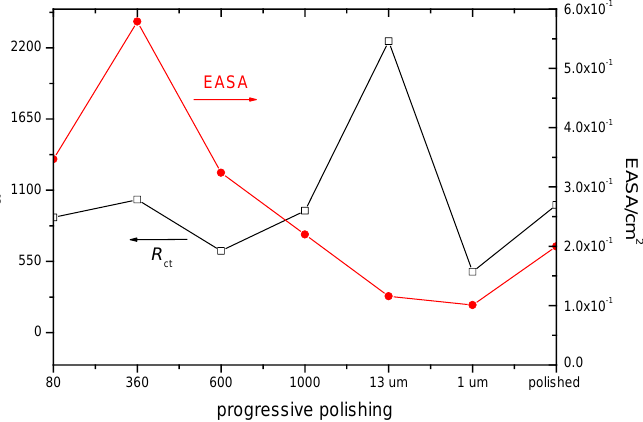
appeared as expected (Figure 4).